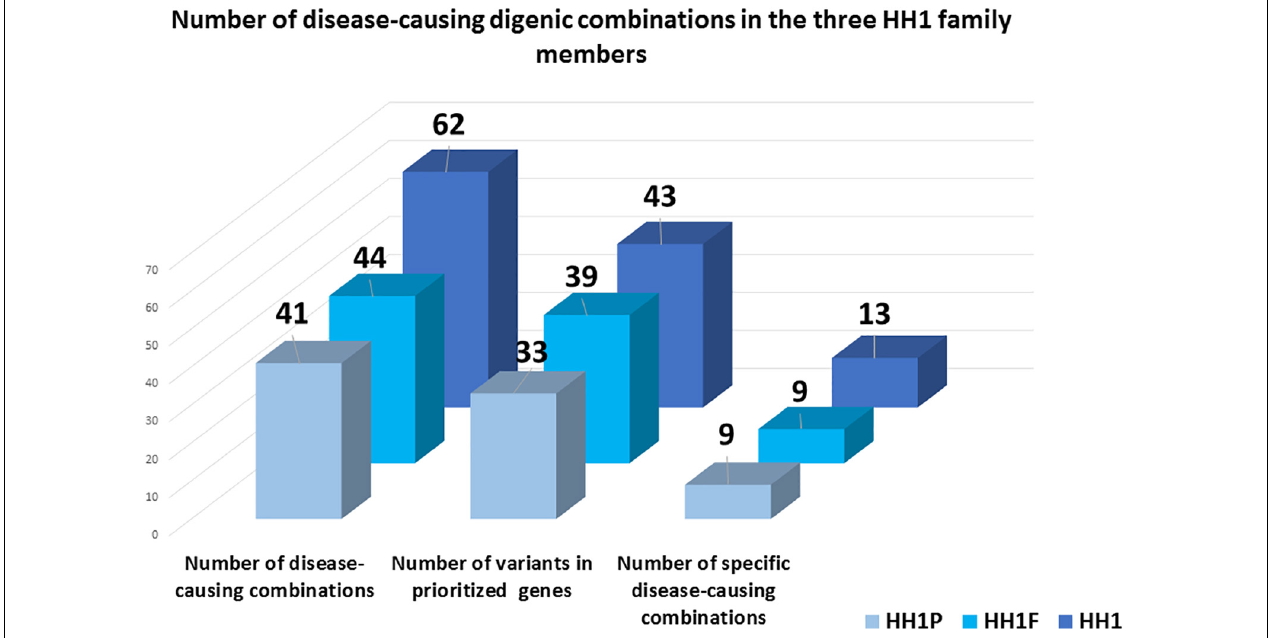
FIGURE 3 | Schematic representation of disease-causing digenic combinations in the three HH1 family members. The histograms correspond to the number of variants in prioritized genes, the total number of pathogenic digenic combinations, and the number of specific pathogenic variant pairs identified in the patient HH1, her asymptomatic brother HH1F, and her father